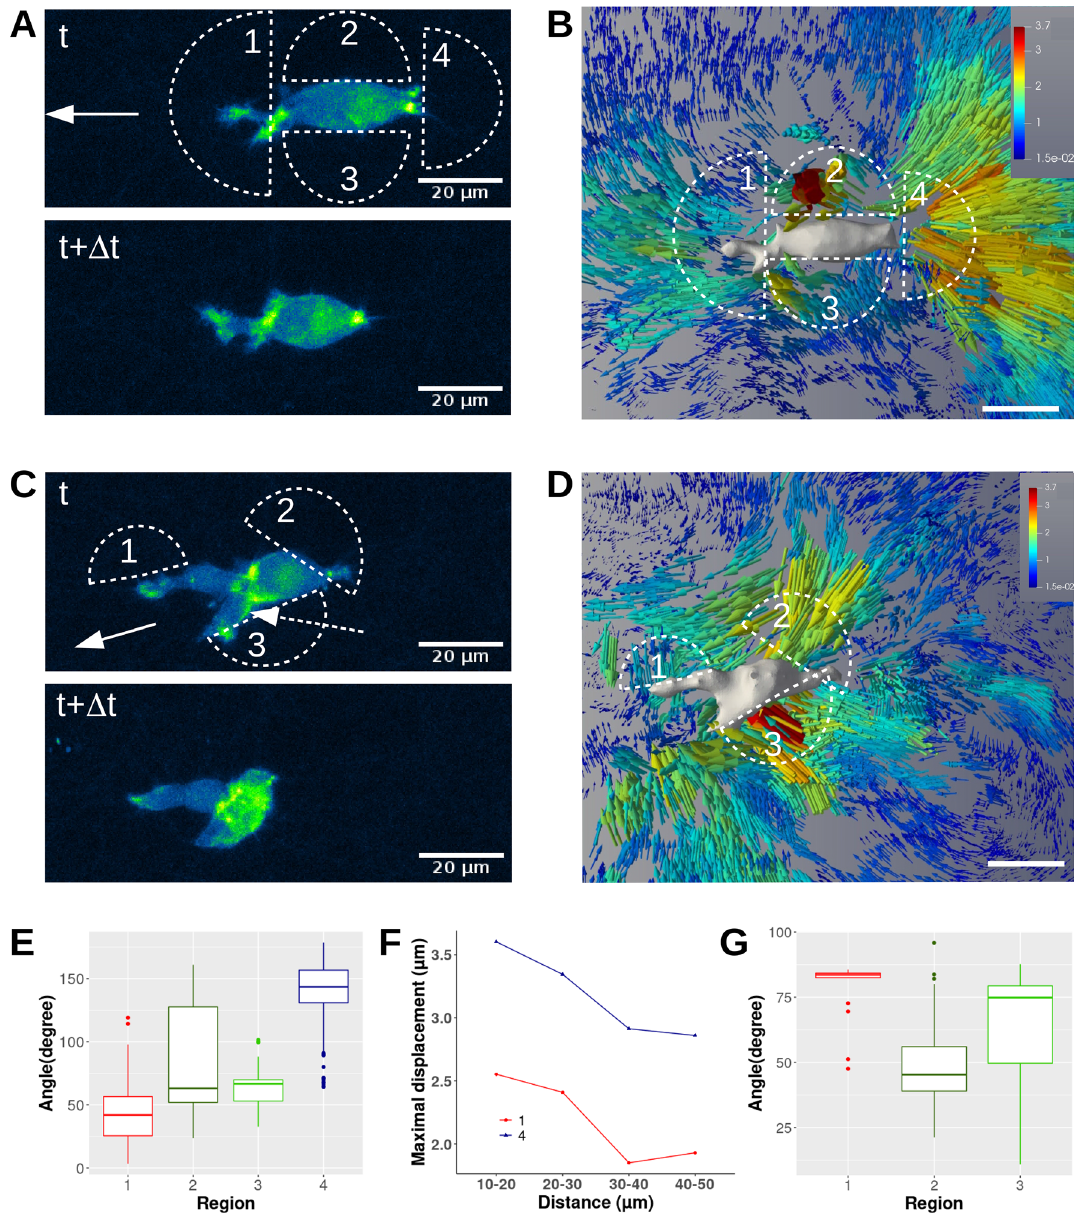
Figure 4. T24 cell migrating in 0.95 mg/mL collagen. ( A ) and ( C ) Two successive images of F-actin (projected Z-stack fluorescence). White half-circles indicate regions of interest. The white arrow indicates the direction of migration whereas the white dotted arrow indicates actin-rich regions inside the nucleus. ( B ) and ( D ) show the collagen fiber 3D-displacement field around the migrating cell. For more visibility, the initial 3D cell shape is shown in grey levels and the displacement field is shown for a half space. Vector lengths and colors indicate the displacement magnitude in μm. Scale bar = 20 μm. ( E ) and ( G ) Box and whisker plots of fiber displacement vector angles versus cell migration direction for regions of interest. ( F ) Maximum displacement amplitudes as a function of cell-fiber distance for the actin-rich regions 1 and 4 in ( A